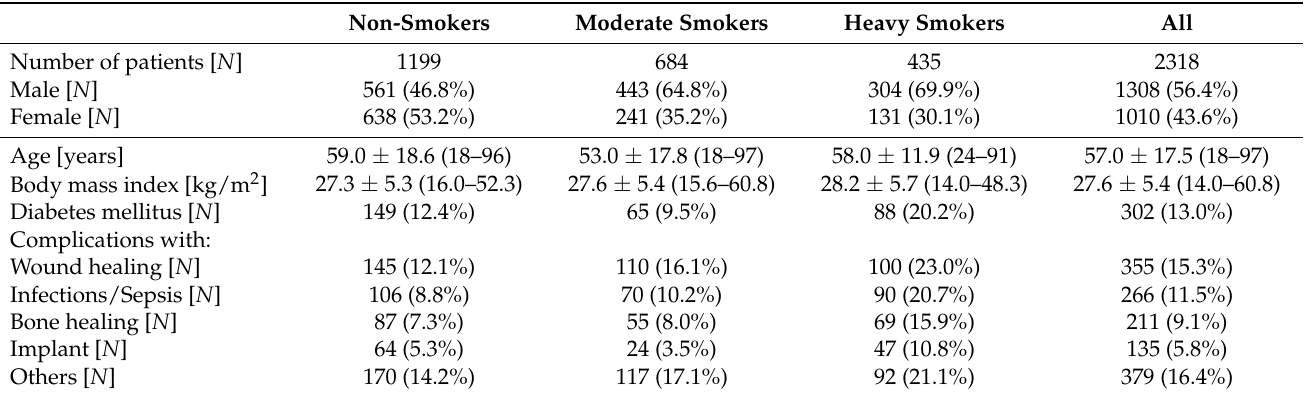
Table 1. Characterization of the patients included in the retrospective data analysis from the hospital information system. Data are presented as absolute numbers [ N ] and percentage or as mean ± standard deviation (range). For complications, one patient might have multiple codings.